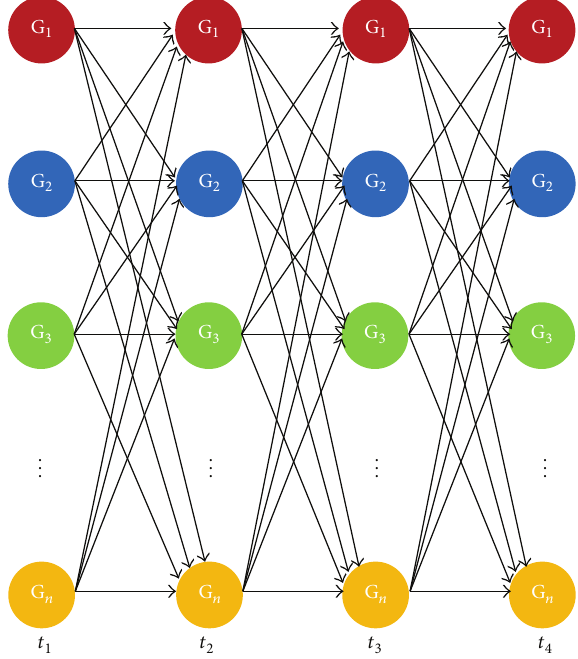
Figure2:RNNmodeldescriptionofageneticnetwork.Thenetwork shown is unfolded from 𝑡 = 𝑡 1 to 𝑡 = 𝑡 4 . Here, all possible connections have been shown among the genes whereas, in reality, such networks are only sparsely